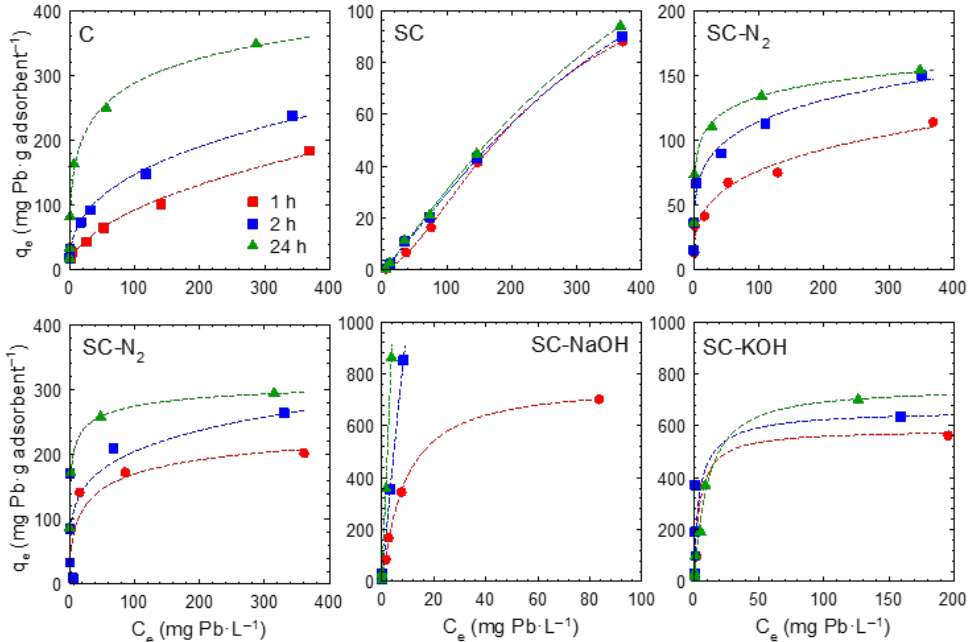
Figure 7. Adsorption isotherms of Pb onto the char from plastic pyrolysis before and after activation. The dashed lines represent the fitting to the Sips isotherm model. Experimental conditions: C Pb0 = 10–500 mg L − 1 ; C adsorbent = 0.5 g · L − 1 ; T = 20 ◦